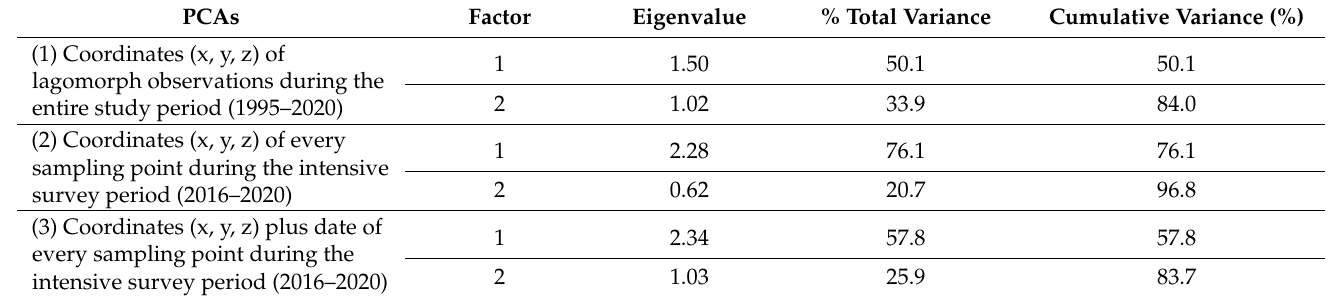
Table 3. Eigenvalues of correlation matrices and percentage of total variance explained by the first two factors of the three principal component analysis applied to the distribution data of hares and rabbits from a Mediterranean agricultural area in S. Spain. Factor Eigenvalue % Total Variance Cumulative Variance (%)